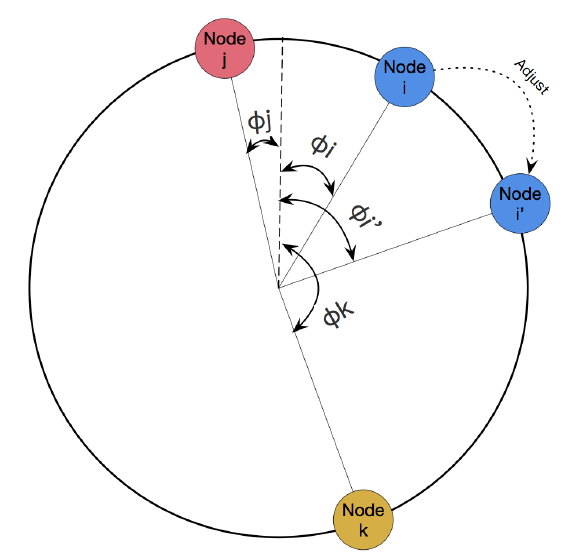
Figure 4. A simple adjustment